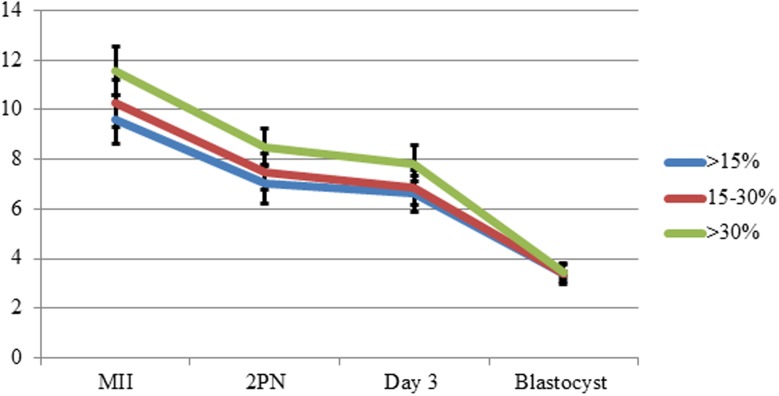
Pre-transfer embryo development (absolute numbers).